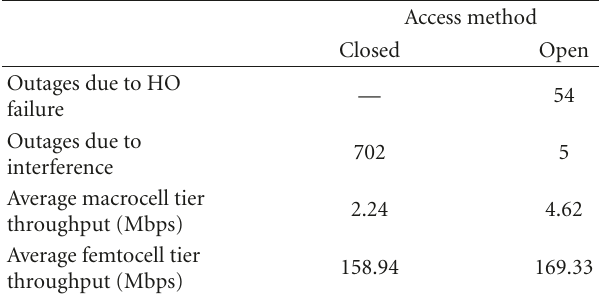
Table 2: Performance